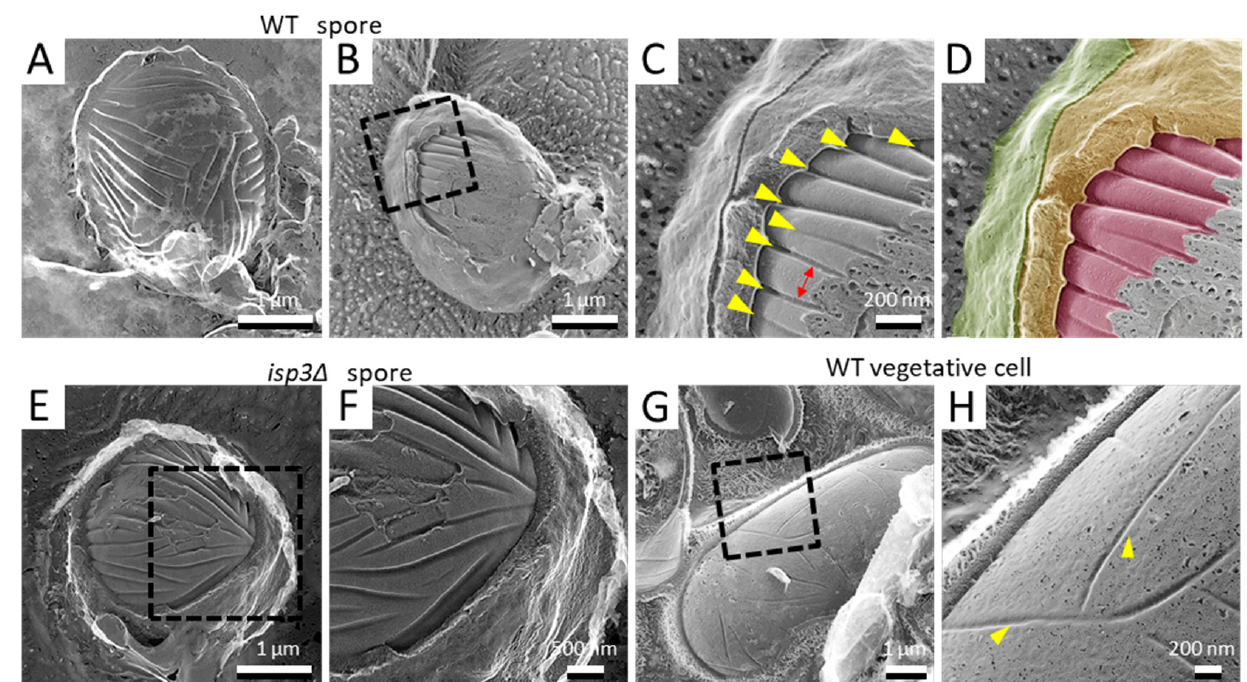
Figure 3. Invagination structure on the membrane surface of spores and vegetative cells. ( A ) Spore with the cell wall detached by fracture. ( B ) Spore with the cell wall and cell membrane partially exposed by fracture. ( C ) Magnified image of the boxed region in B. Yellow arrowheads indicate invaginations of the membrane surface. Arrow indicates the interval of the invaginations. ( D ) Colored image of ( C ). The fibrillar layer is colored green, the spore wall yellow, and the spore cell membrane red. ( E ) isp3 ∆ spore with a fractured spore wall. ( F ) Magnified image of the boxed region in ( E ). ( G ) Vegetative cell surface with fractured cell walls. ( H ) Magnified image of the boxed region in ( G ). Arrowheads indicate invaginations of the membrane surface.